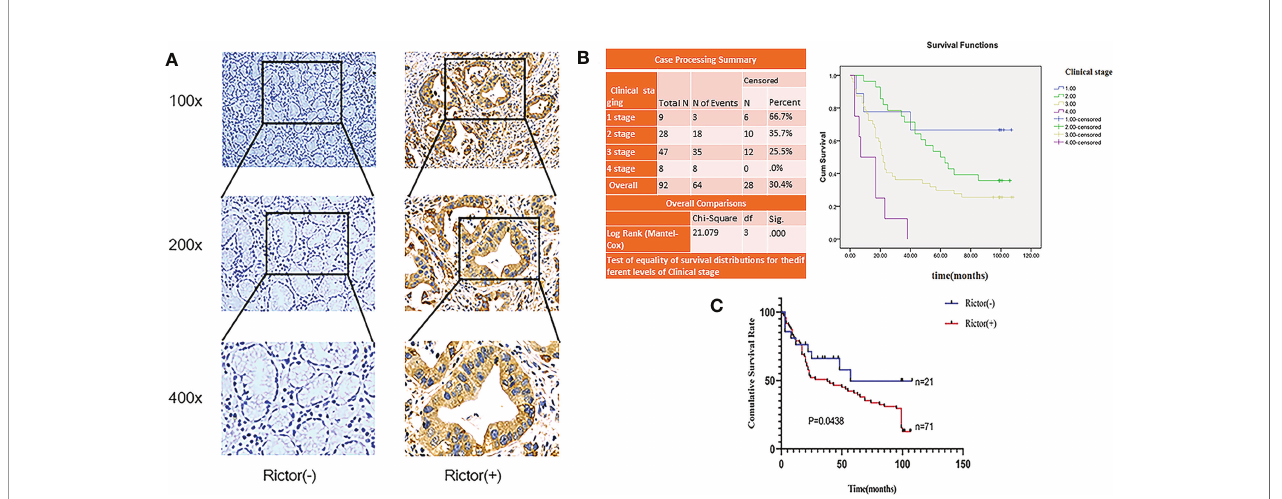
FIGURE 1 | Rictor is upregulated inside GC cells and correlated with poor prognosis in different GC cohorts. (A) Representative immunohistochemical stains for Rictor. (B) Kaplan-Meier survival analysis with log-rank test for OS in all 92 patients with gastric cancer sorted by immunostaining of Rictor. (C) Survival analysis of 92 gastric cancer